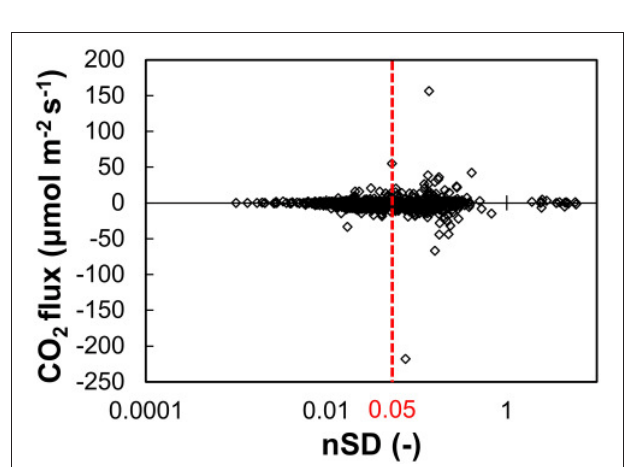
FIGURE 7 | Comparison between the effects of the filtering parameter and the CO 2 flux after the RSSI filtering procedure. The threshold (broken red line) was determined so as to remove the confirmed low-quality data. Normalized standard deviation (nSD) is the standard deviation over 30-min interval divided by the average during the entire measurement period (threshold = 0.05; 74% of data